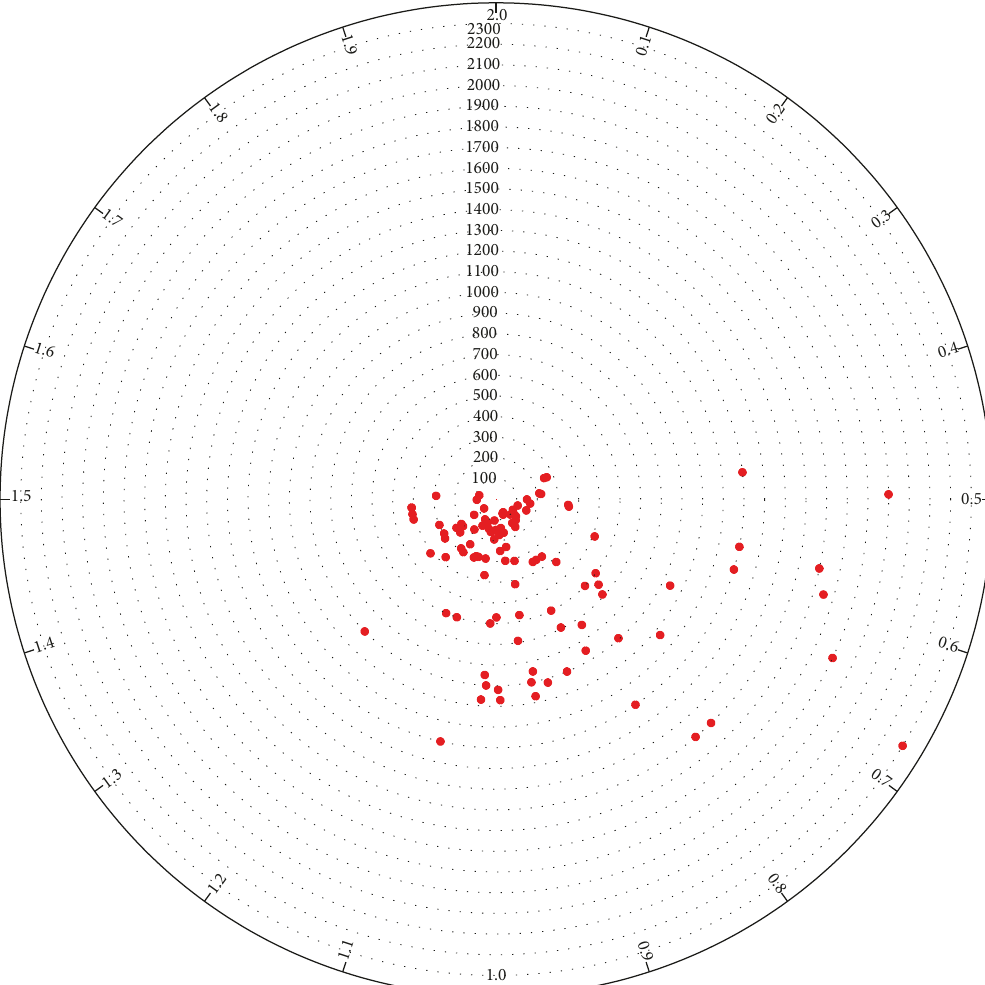
Figure 7: Distribution of the ratio of maximum and minimum principal stress difference and vertical stress with buried Figure 7. Shear failure is a common form of rock failure. The K H-h ratio of principal stress difference and vertical gradient is greater. The higher the shear stress of rock mass, the greater the probability of damage.